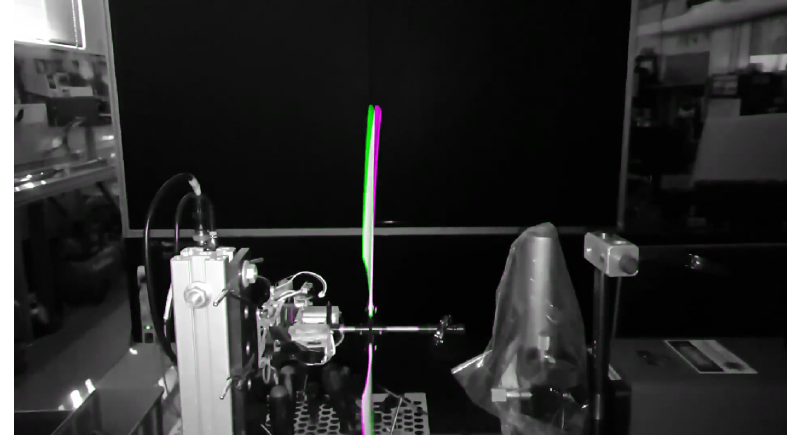
Figure 18. Comparison of the blades’ rotating position before (purple) and after (green) reducing